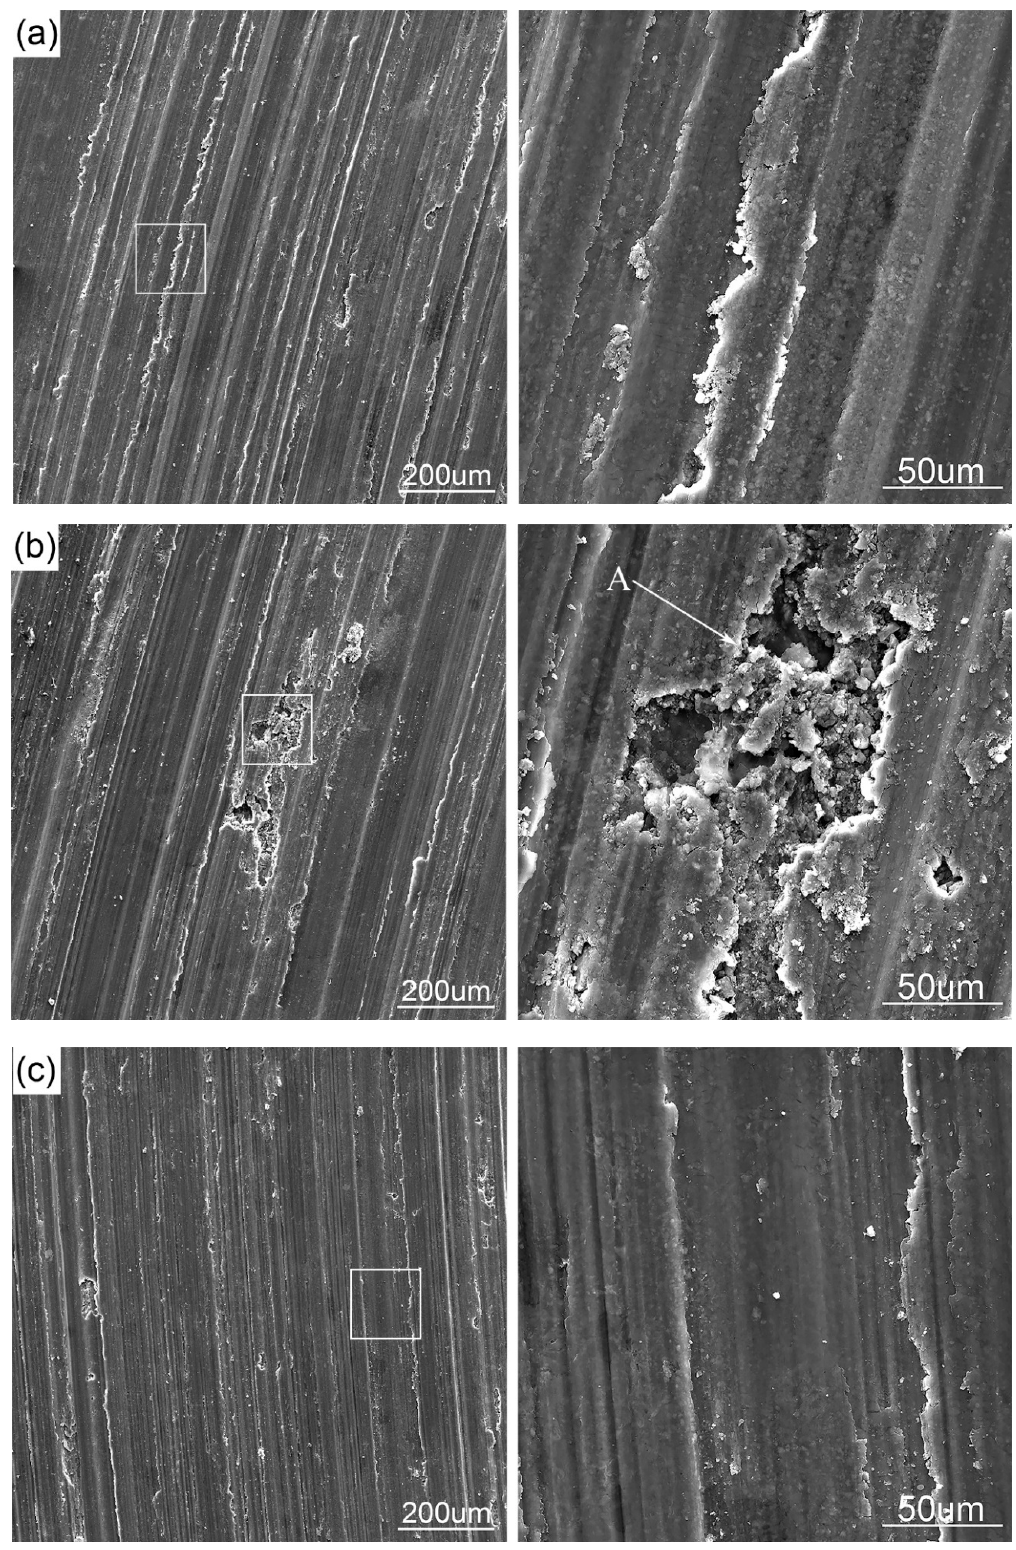
Figure 11. SEM micrographs of worn out surfaces for AlSi5Cu1Mg + 0.6 wt % La alloys subjected to: ( a ) 0.19 m/s sliding velocity and 1.3 MPa normal load; ( b ) 0.19 m/s sliding velocity and 6.3 MPa normal load; ( c ) 0.57 m/s sliding velocity and 1.3 MPa normal load, and the high magnification micrographs are on their right side.